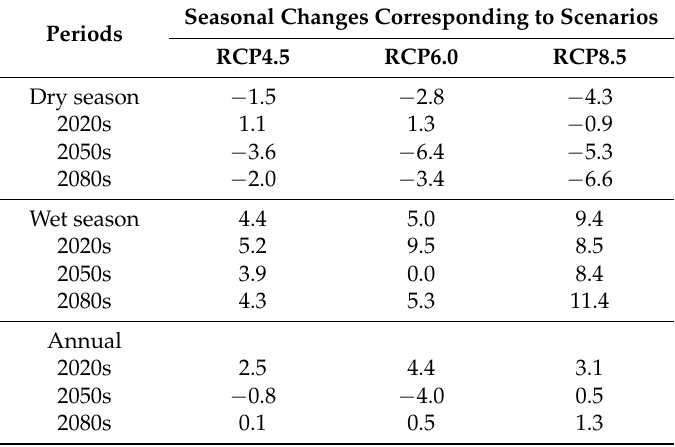
Table 6. Annual changes in future streamflow under the RCP45, 60 and 85 scenarios. Seasonal Changes Corresponding to Scenarios Periods